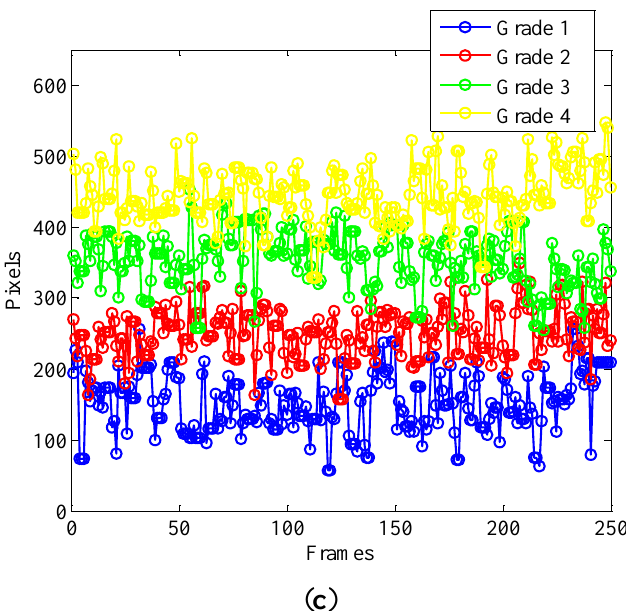
Figure 11. Distribution curves of white spot pixels in UV images. ( a ) RH = 80%; ( b ) RH = 85%; ( c ) RH =